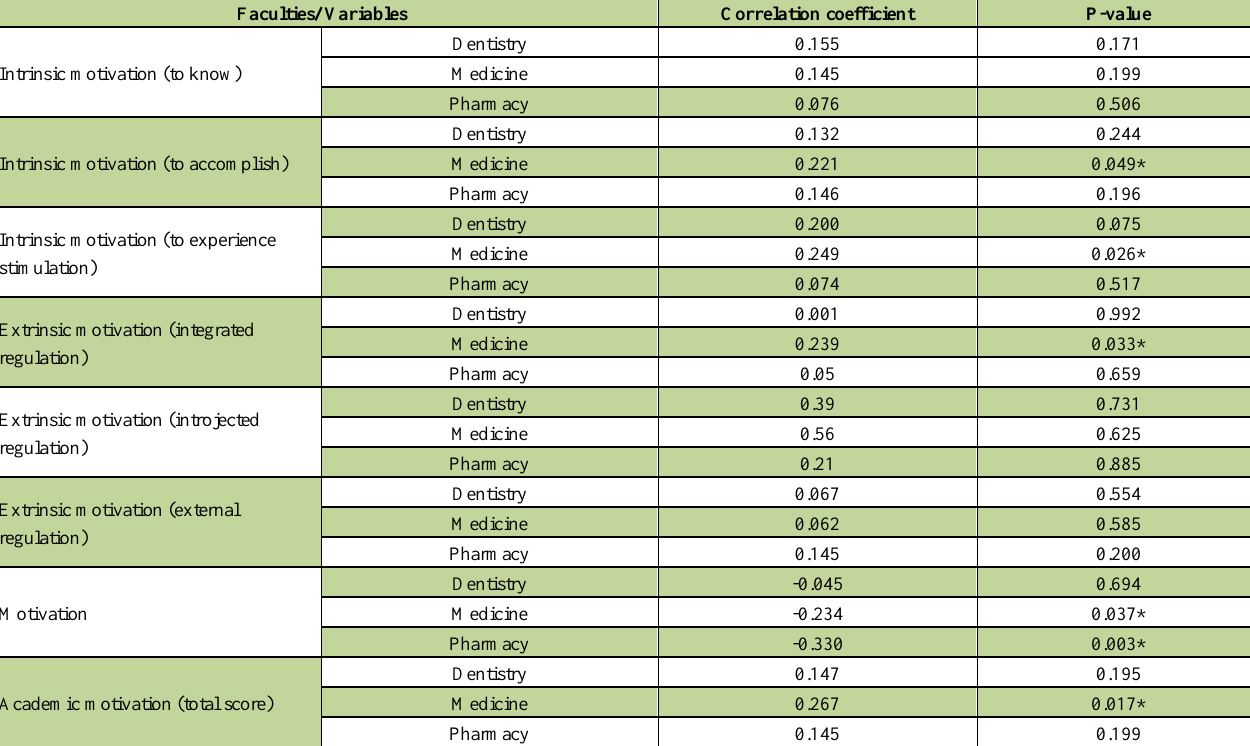
Table 5. Correlation between academic motivation and its subscales with academic achievement in